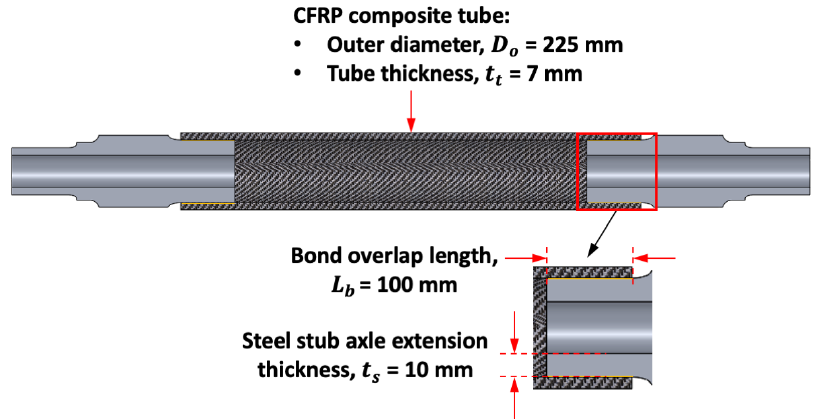
Figure 9. The optimised structural hybrid metallic-composite railway axle (outboard) design concept showing final dimensions with an assembly mass of 200 kg.